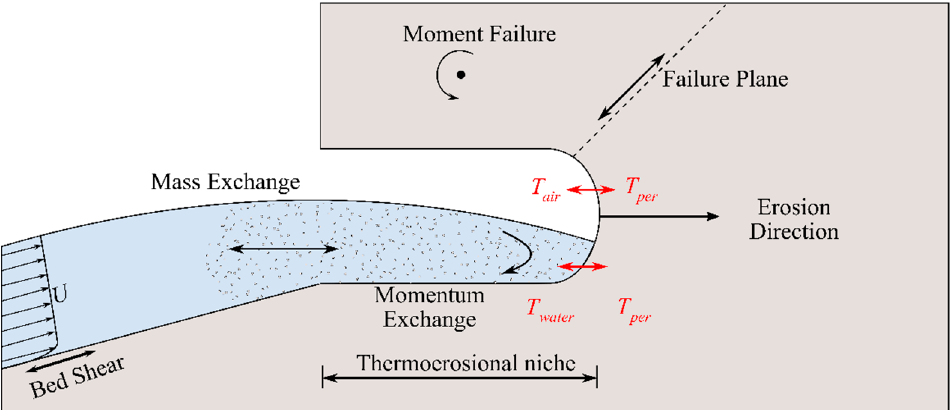
Figure 2. Visualization of erosion mechanism for the development of a thermoerosional niche and subsequent block failure. Photographic illustrations of the block failure process can be found, e.g., [12].